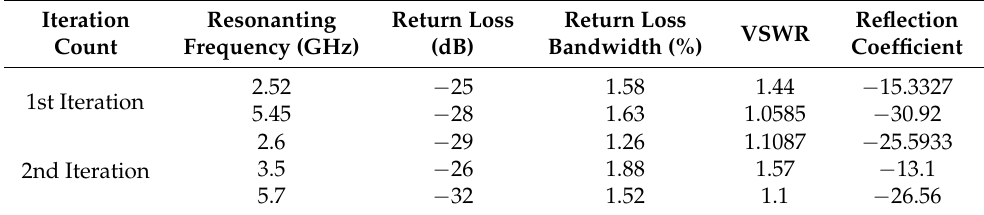
Table 3. Comparative analysis of proposed fractal geometry for various